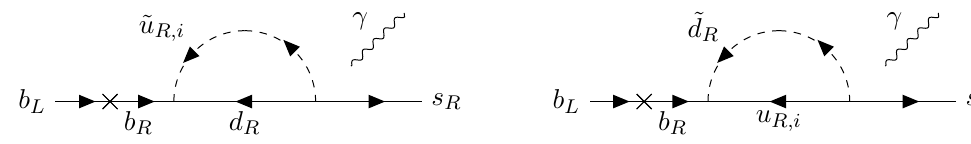
s(cid:13) mediated by RPV interactions. The !